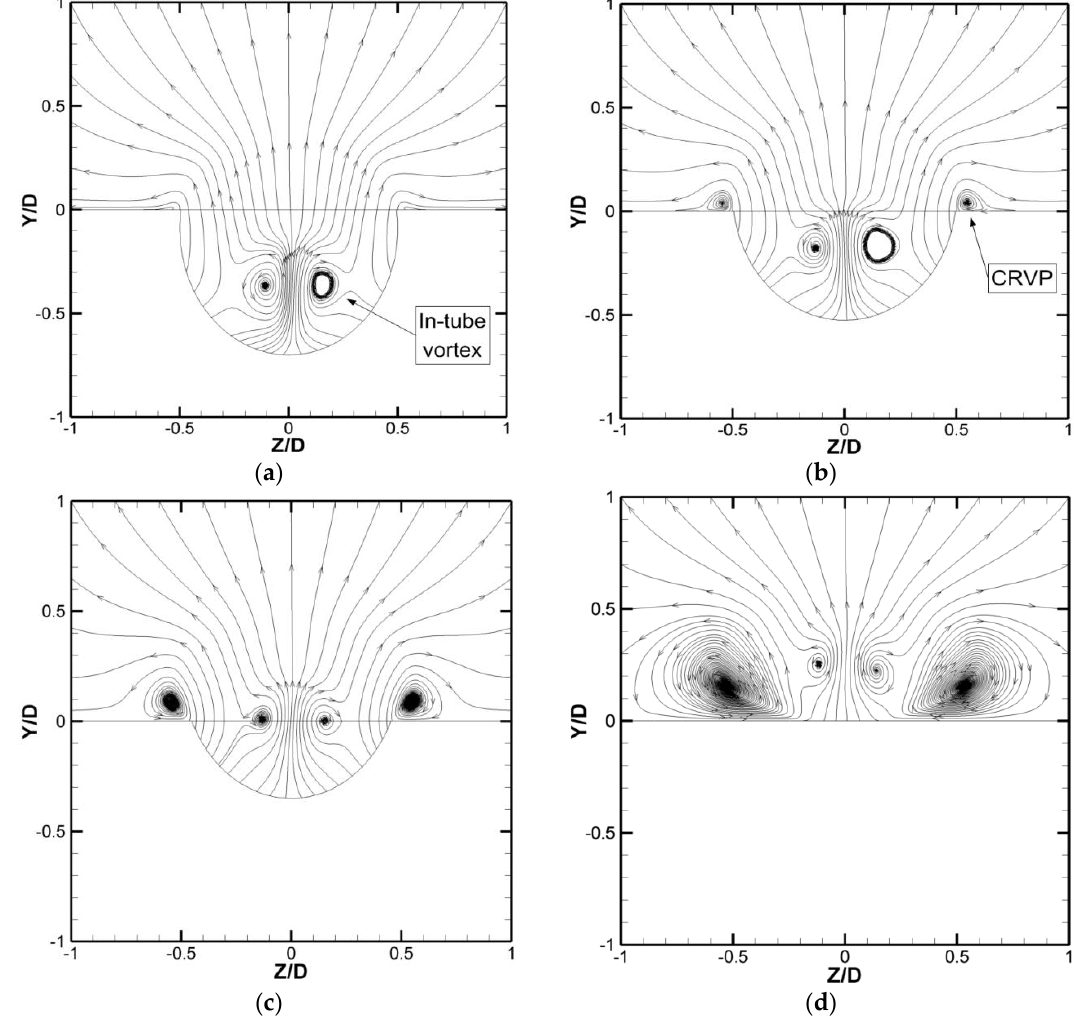
Figure 5. 2D streamlines of the unsteady case at the Y-Z planes close to the exit. ( a ) X/D = −1; ( b ) X/D = −0.75; ( c ) X/D = −0.5; ( d ) X/D = 0.